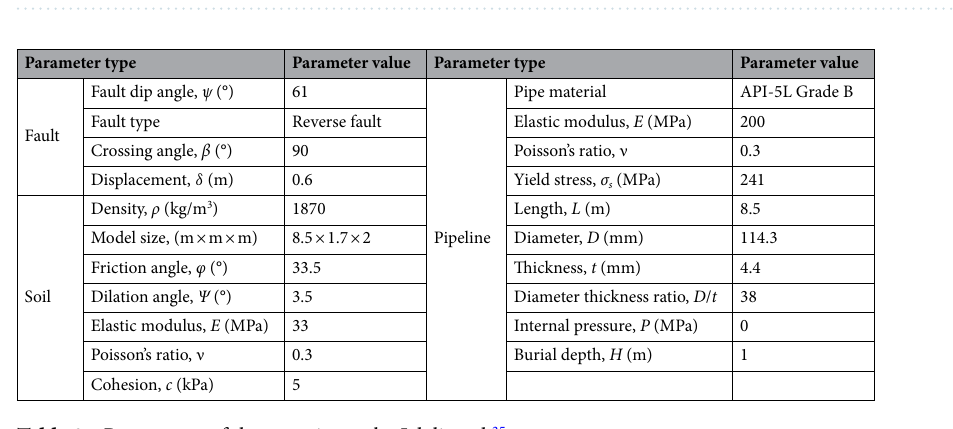
Table 2. Parameters of the experiment by Jalali et al. 35